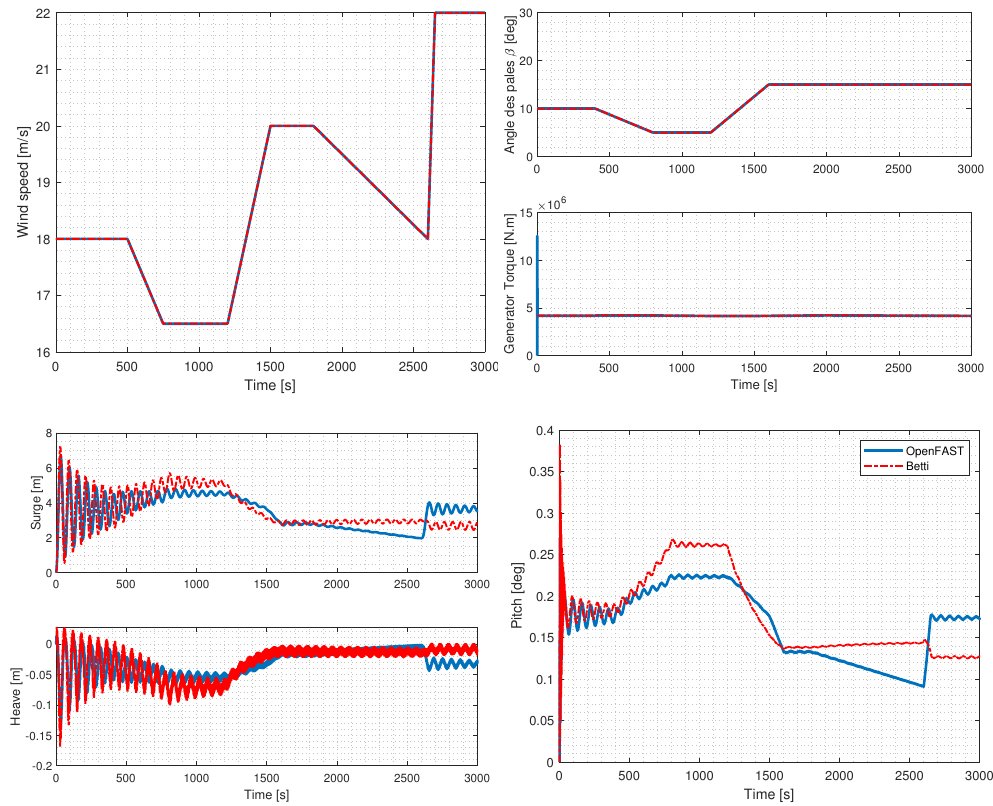
Figure 4. Simulation comparison following [4] conditions with OpenFAST code in blue and Betti model in red: wind speed profile ( top-left ), generator torque and blade pitch angle control inputs ( top-right ), surge and heave translational DOFs ( bottom-left ) and pitch angular DOF ( bottom-right ). The produced surge, heave and pitch DOFs are relatively closed to OpenFAST